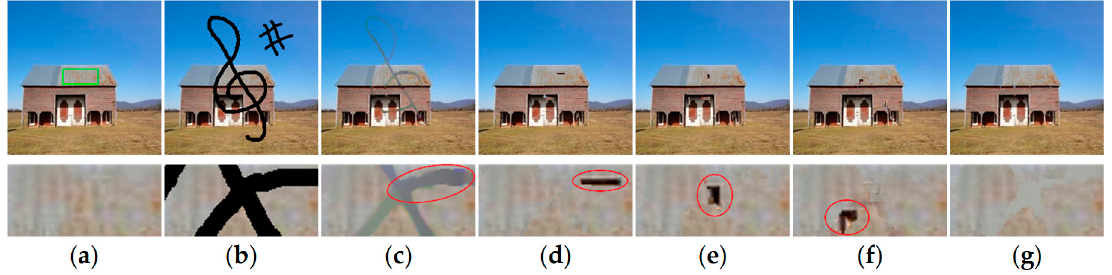
Figure 8. Comparison of inpainting results for House (512 × 512): ( a ) Ground truth; ( b ) incomplete image; ( c ) CDD model [4]; ( d ) Criminisi’s method [10]; ( e ) Liu’s method [17]; ( f ) Zhou’s method [18]; ( g ) proposed method.